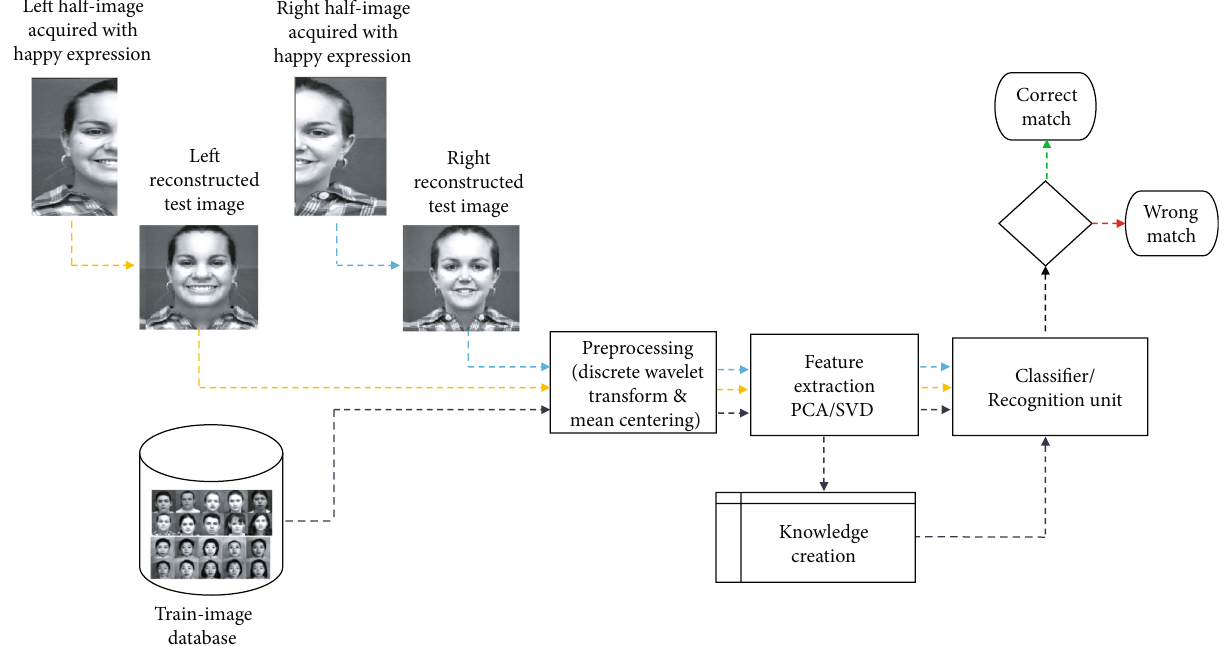
Figure 5: Research